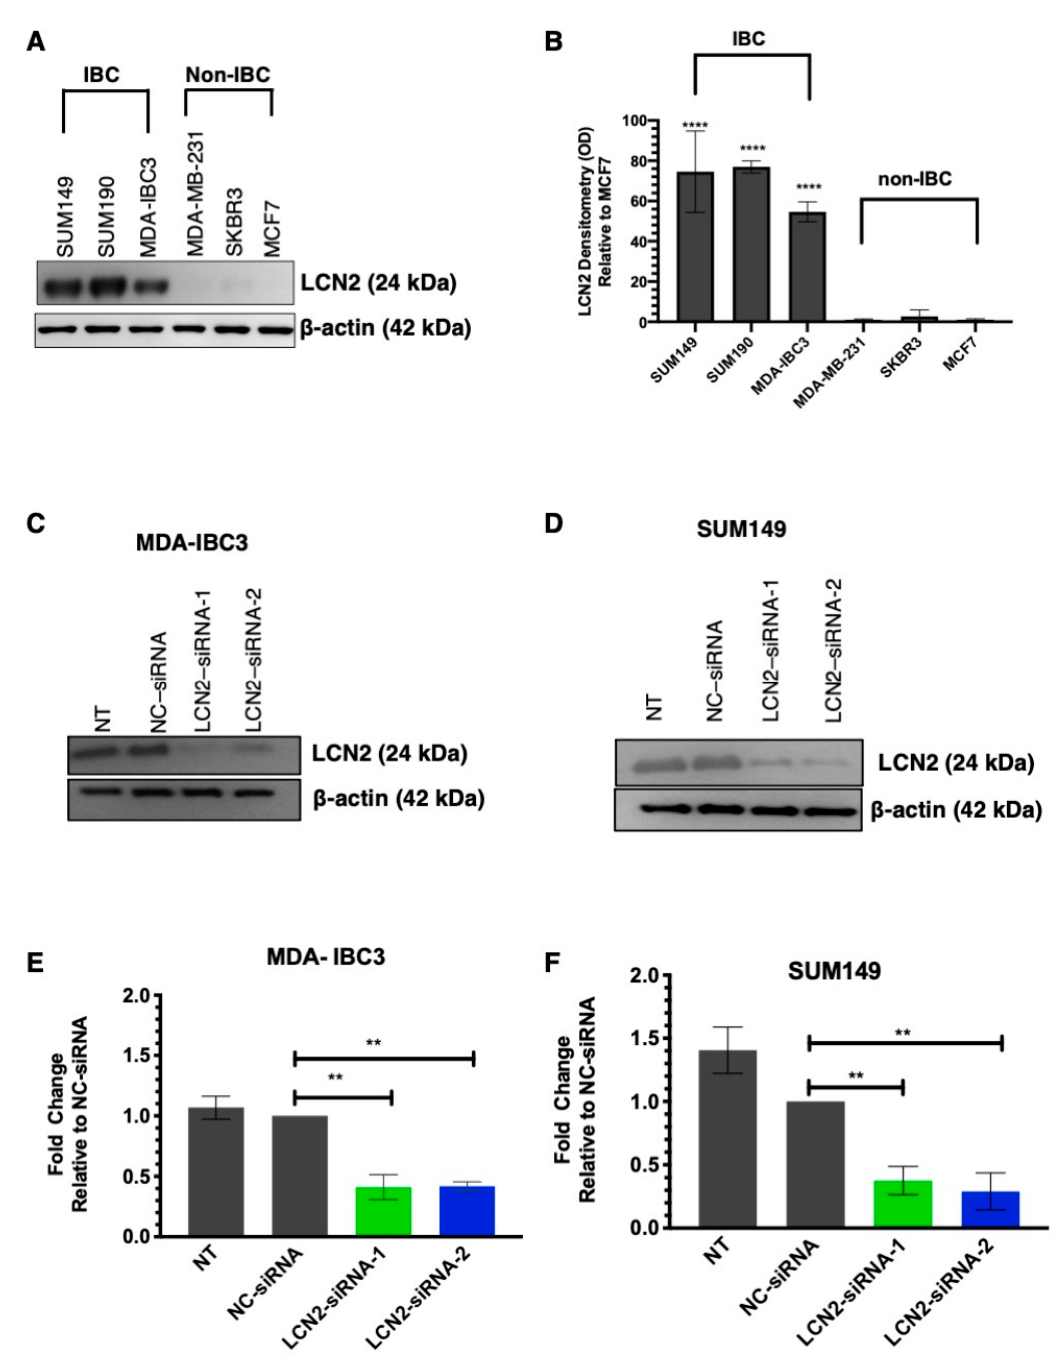
Figure 1. siRNA-based silencing in LCN2-overexpressing IBC cells. ( A ) Western blot analysis for LCN2 and β -actin (as loading control) in a panel of IBC (SUM149, SUM190, and MDA-IBC3) and non-IBC (MDA-MB-231, SKBR3, and MCF7) cells. ( B ) Densitometric analysis of band intensities was performed, and values were calculated relative to non-IBC cells, MCF7. Results are shown as Mean ± SEM of triplicate experiments, **** p < 0.001). Two different siRNAs targeting exon 3 and exon 5 of the human LCN2 sequence (NC_000009.12) were used. Western blot analysis of ( C ) MDA-IBC3 cells and ( D ) SUM149 cells were performed after transiently transfected with LCN2-siRNA-1, LCN2-siRNA-2, and negative control-siRNA (NC-siRNA) at 100 nmol/L concentration, as described in materials and methods. Non-treated (NT) cells were treated with the transfection reagent. Densitometric analysis of band intensities of ( E ) MDA-IBC3 and ( F ) SUM149 cells was calculated relative to the NC-siRNA. Results are shown as Mean ± SEM of triplicate experiments (** p <